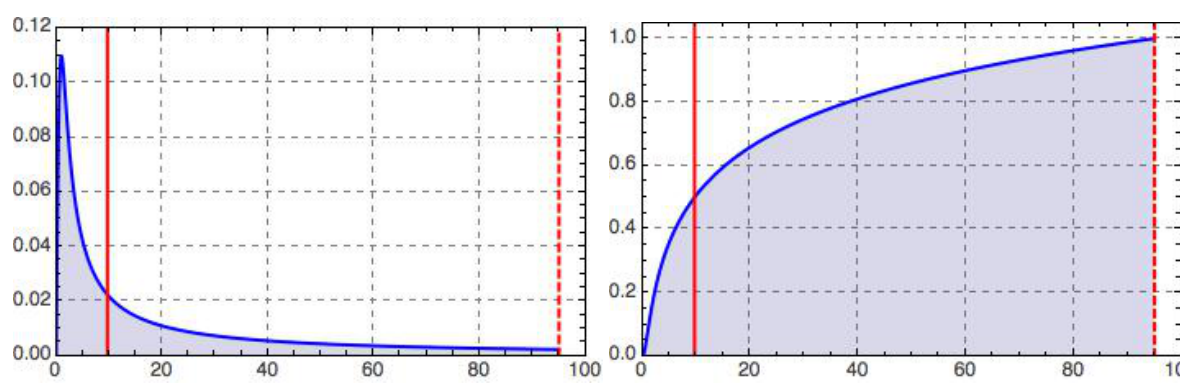
Figure 2. Retino-cortical magnification, V (cid:48) ( t, T ) ( left ), and its integral, V ( t, T ) ( right ), as a function of dimensionless eccentricity, t , illustrated for the case T = 95 (dashed vertical line); recall Equations (12)–(15). The peak on the left occurs at t ρ = a of the geometric foveola. The half maximum on the right is reached at t + corresponding to the geometric equipartitioning radius (left vertical line), ρ = 1 , T = 95) ≈ 8% ; recall Equation processing capacity v ( t +